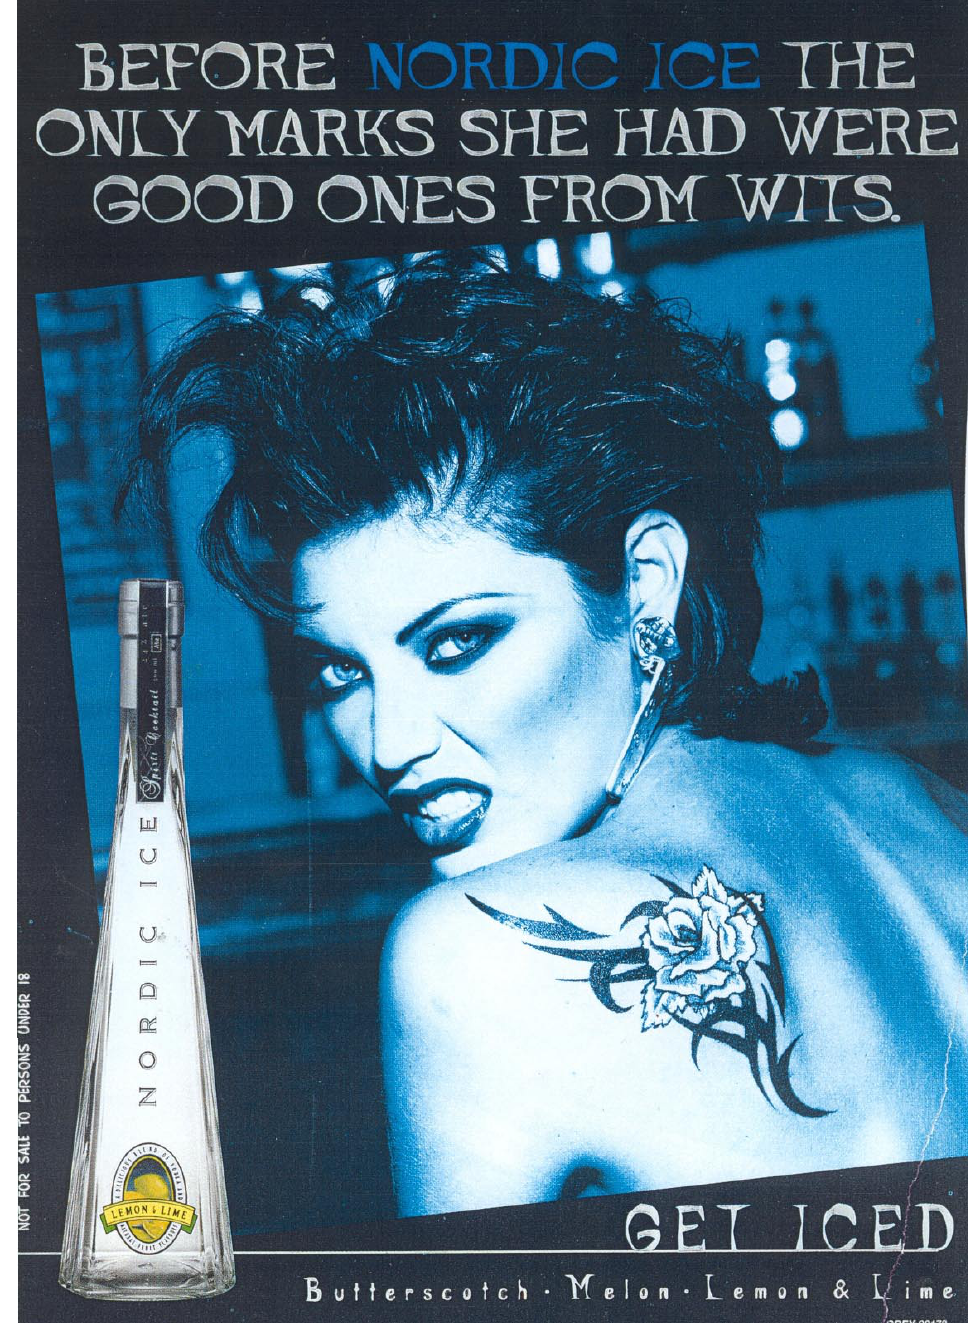
Figure 2: Nordic ice